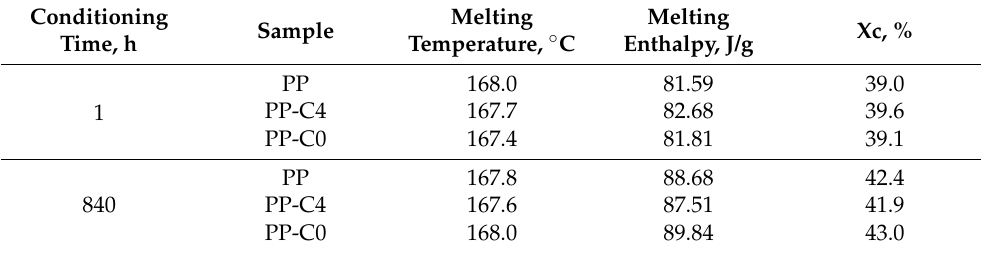
Figure 5. DSC melting curve of PP samples conditioned for 1 h ( a ) and 840 h ( b ) .